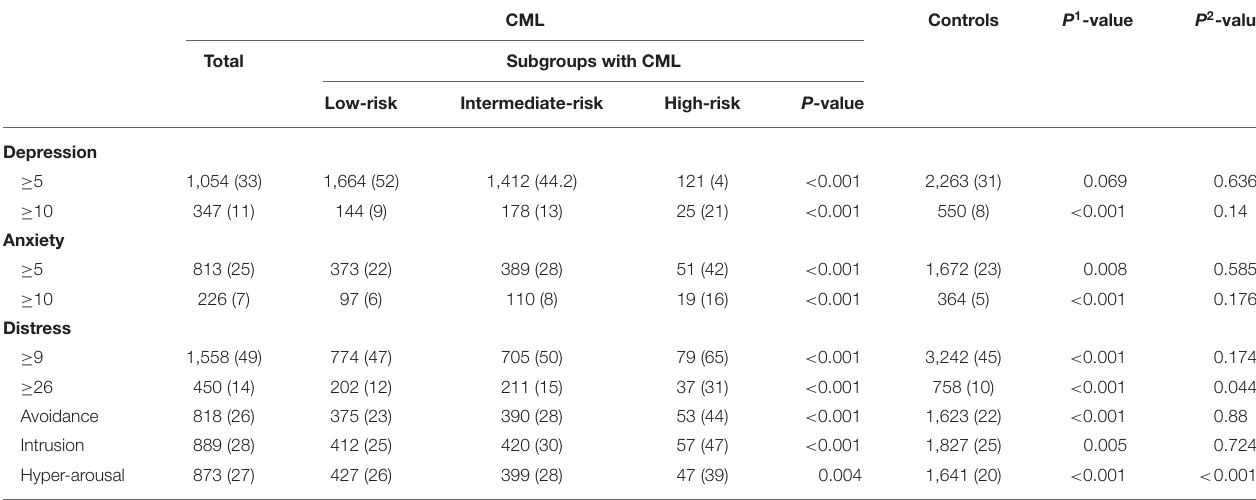
TABLE 2 | Comparison of mental health of respondents with CML and